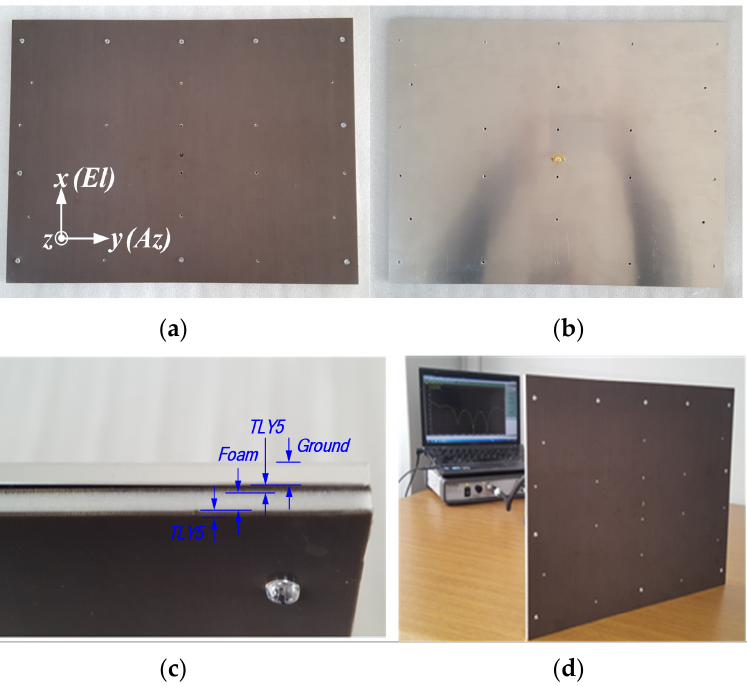
Figure 9. Photograph of the fabricated array antenna: ( a ) front view; ( b ) back side; ( c ) side view; ( d ) measurement setup in the lab.